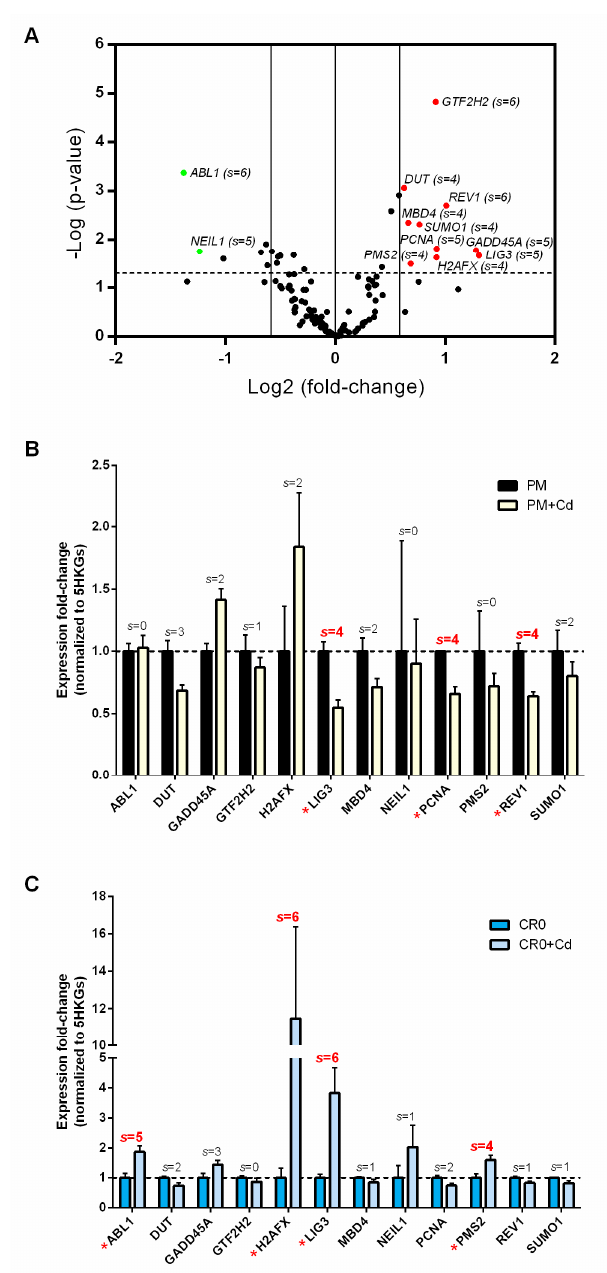
Figure 3. DNA repair gene expression profile associated with Cd exposure. ( A ) Volcano plot of 117 DNA repair gene expression profiles of CR0 over PM cells when normalized to 5-housekeeping genes (5HKGs), modified from Figure S3F. Only expression of genes with an s -score ( s ) ≥ 4 were considered as significantly altered and highlighted in green (down-regulated) or red (up-regulated). Specifically, to gain an s -score ( s = 1), a gene has to be p ≤ 0.05 and fold-change ≥ 1.5 upon normalization to a selected reference gene. Six references genes ( ACTB , B2M , GAPDH , HPRT1 , PRLP0 , and 5HKGs) were used. Vertical lines on the x -axis represent 1.5 or –1.5 fold-change; dash line on the y -axis represents p ≤ 0.05. ( B , C ) Expression of the 12 di ff erentially expressed DNA repair genes in PM and CR0 cells treated with 20 µ M of CdCl 2 for 72 h. Only expressions of genes with s ≥ 4 (highlighted in red asterisk) were considered significantly altered.